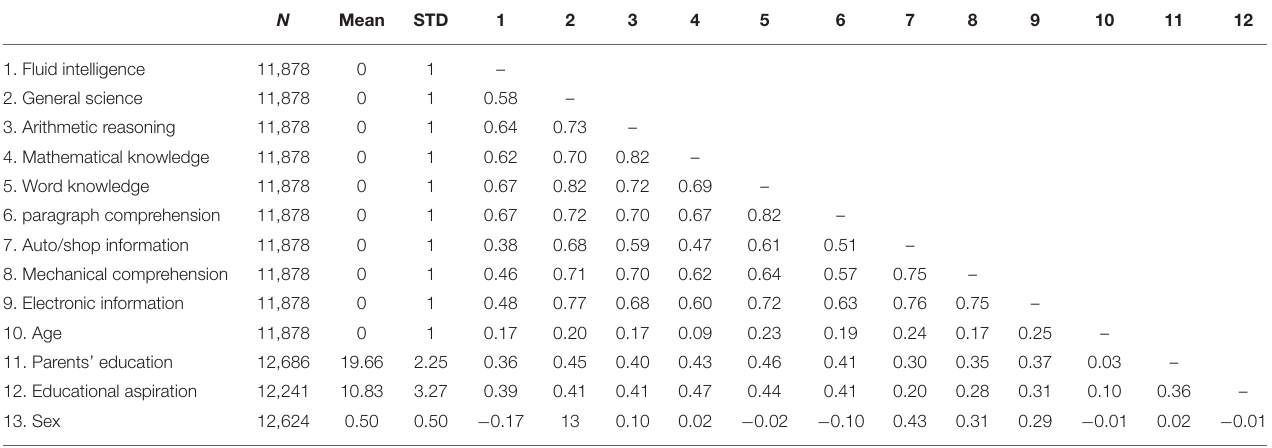
TABLE 2 | Inter-correlations of dependent and independent